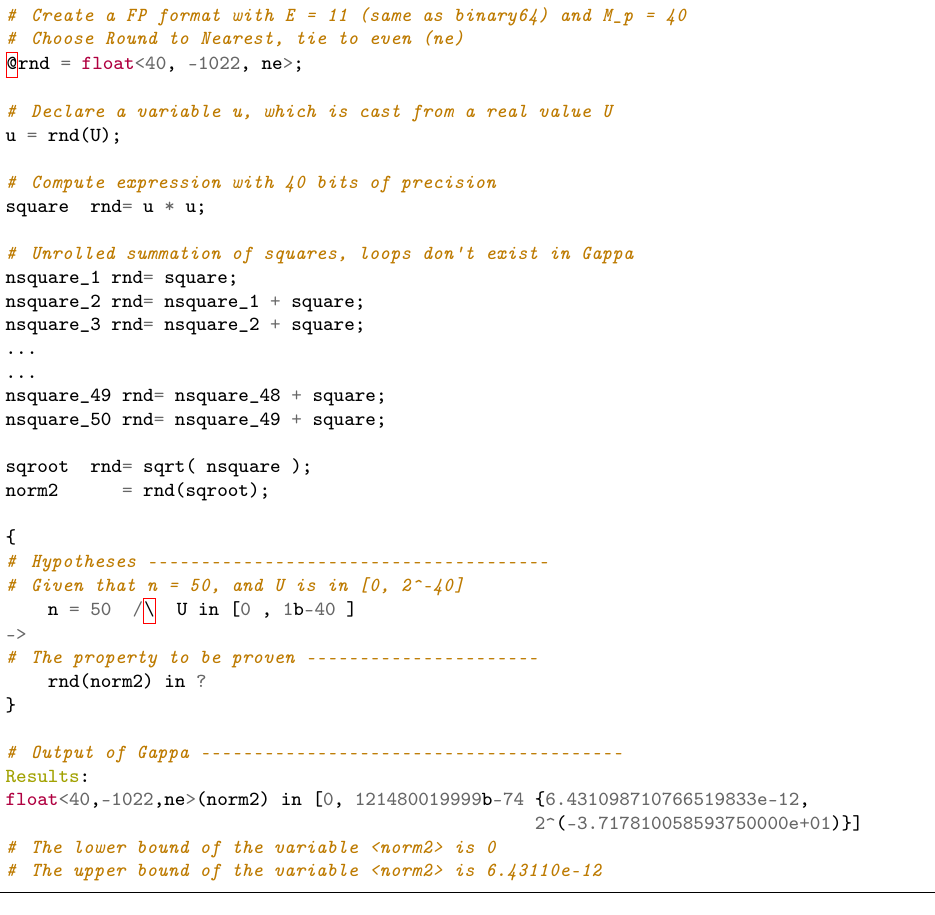
(cid:126) b ( k + 1 ) A (cid:126) x ( k + 1 ) ). || − ||